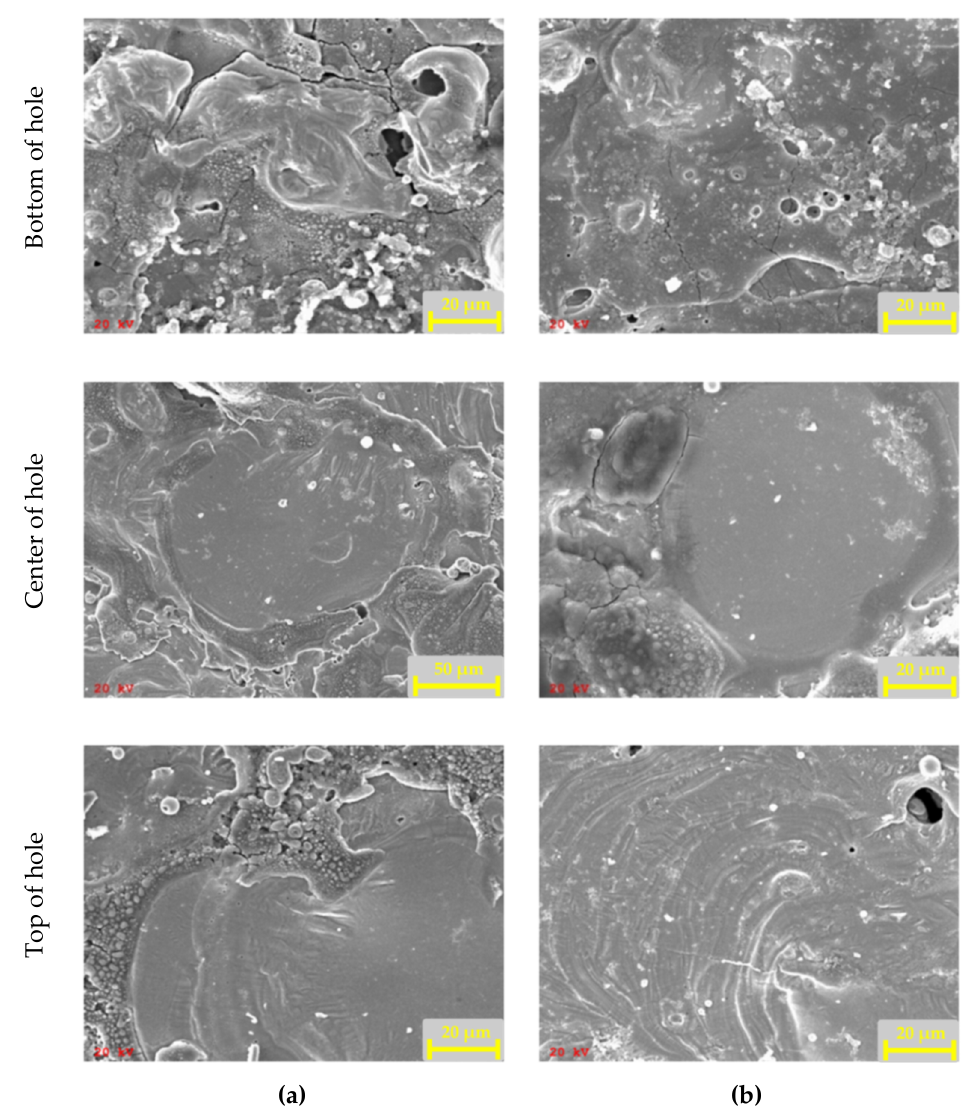
Figure 16. SEM images of selected internal surfaces of the hole: Bottom, center, and top. Machining parameters: ( a ) U = 80 V, t i = 818 µ s, I = 4.32 A, and AR = 10; ( b ) U = 80 V, t i = 818 µ s, I = 3.33 A, and AR = 6.